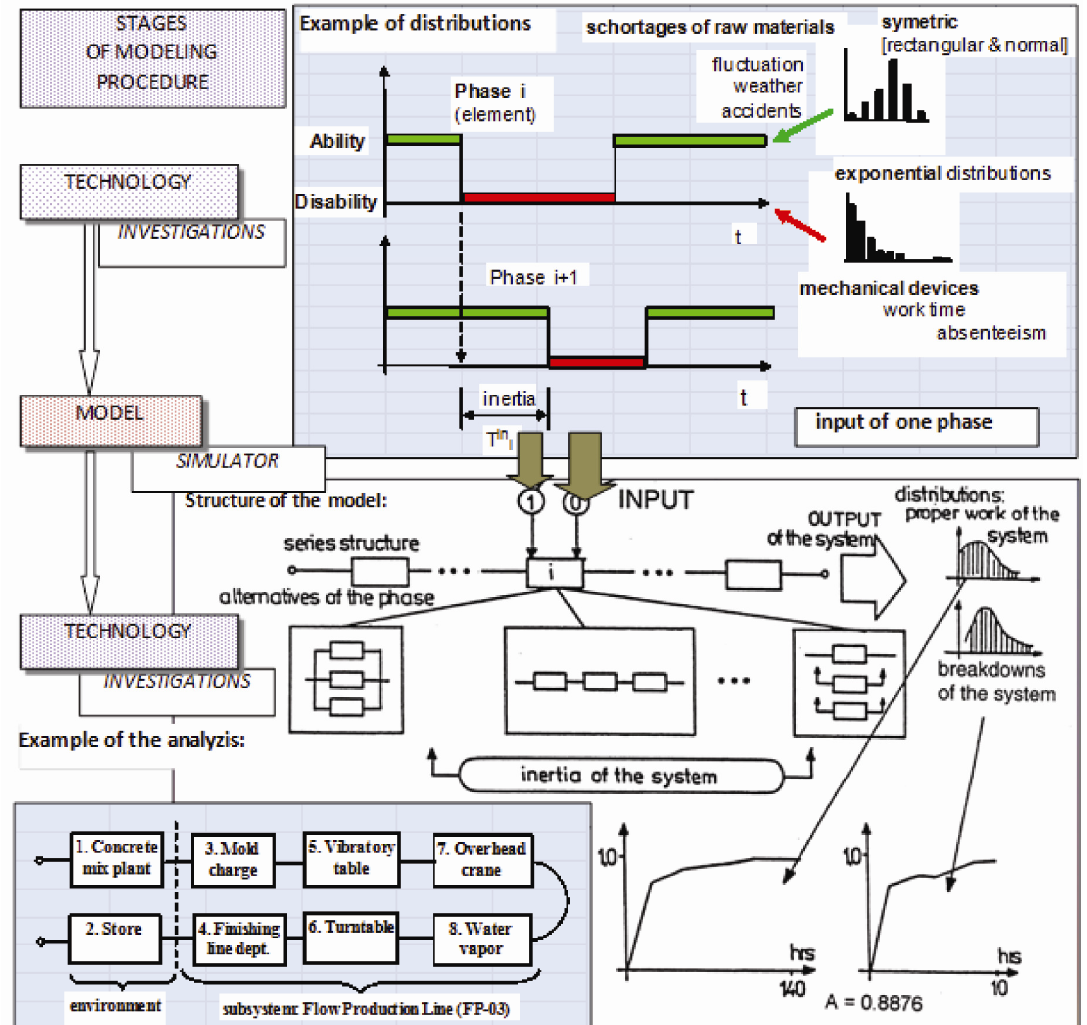
Fig. 2. Synthesis of the extended method of testing reliability and operation of production systems (Kapli ñ ski